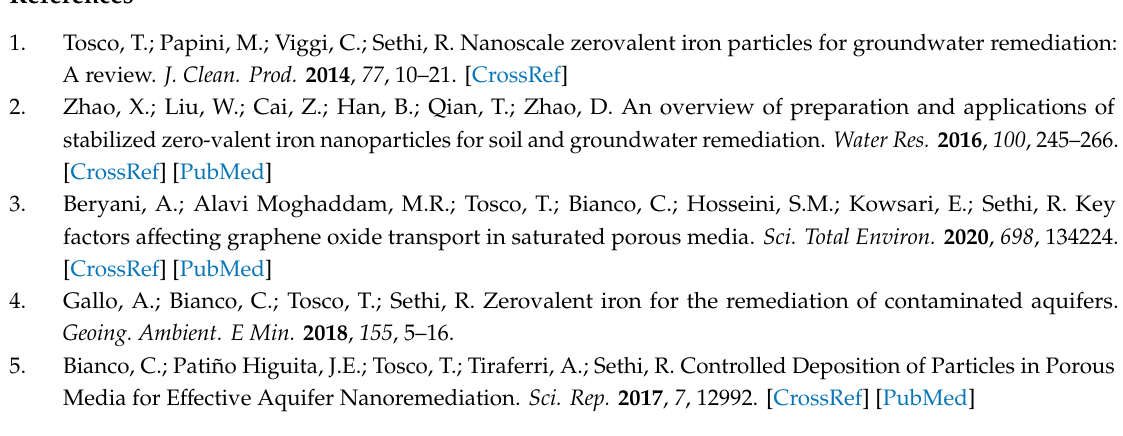
Figure S1: Pressure drop over time recorded for the column transport tests of mZVI particles at di ff erent discharge rates, Table S1: Shear rate and viscosities in the porous medium for di ff erent column tests, Figure S2: Breakthrough curves, iron concentration profiles and pressure drop along the column for mZVI transport tests, Table S2: Transport and clogging parameters from fitting of mZVI column transport tests, Figure S3: Trend of attachment coe ffi cients derived from column test interpretation, Figure S4: Pressure drop along the column for the gel filtration test, Table S3: Model parameter implemented in the radial model, Table S4: Cross parameters of bulk viscosity curves, Figure S5: Experimental and modelled radial tracer test, Figure S6: Time evolution of mZVI injection in the radial